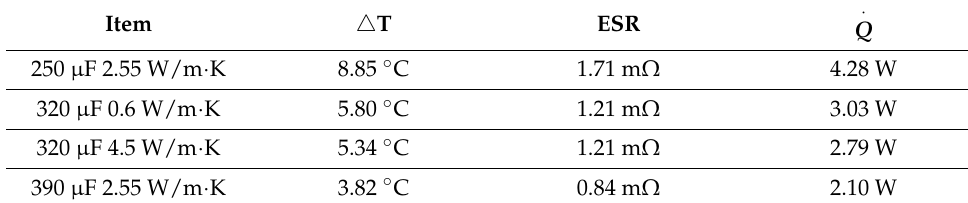
Figure 3. Finite element analysis (FEA) results of capacitance and thermal conductivity of epoxy for film thickness 2.8 µ m. Table 4. Analysis results for film thickness 2.8 µ